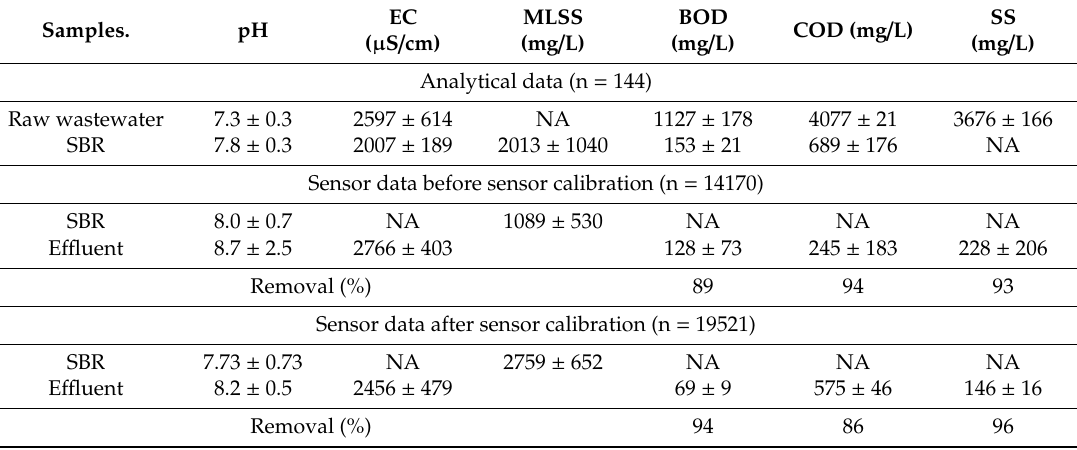
Table 6. Removal e ffi ciency of BOD, COD, and SS of the piggery wastewater based on the sensor data.